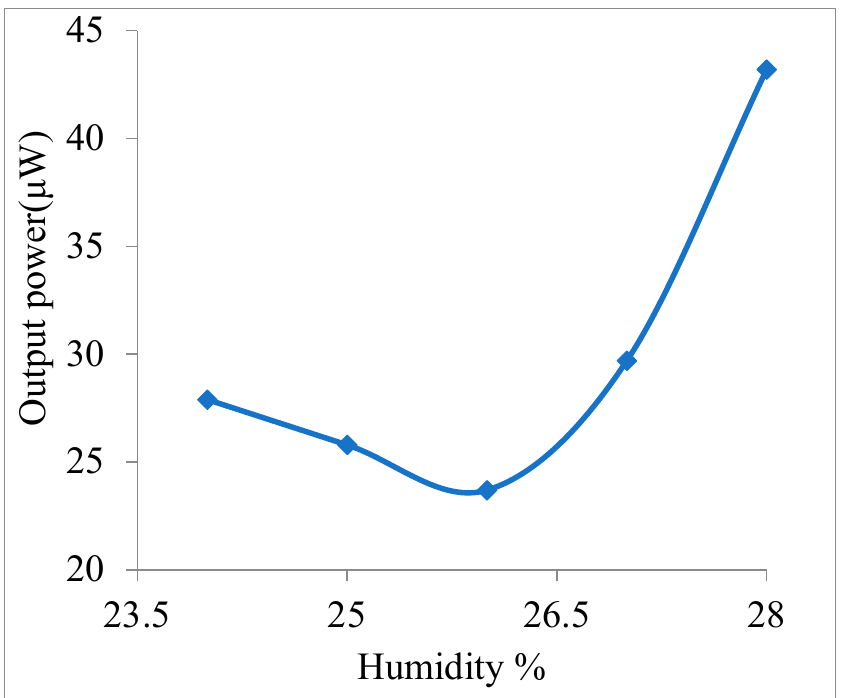
Figure 6. Output power with the humidity. Other parameters were constant. The speed of air was around 2.6 m/s, temperature was 34 °C, gross area of each antenna was 72 × 72 cm 2 , and the square-shaped antenna gap was 24 × 24 cm 2 .